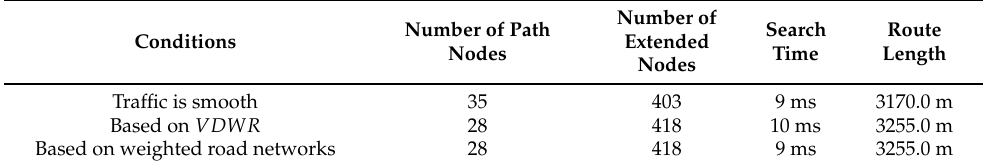
Table 2. Crowded Road is Located Near the Origin While Driving a Relatively Short Distance.